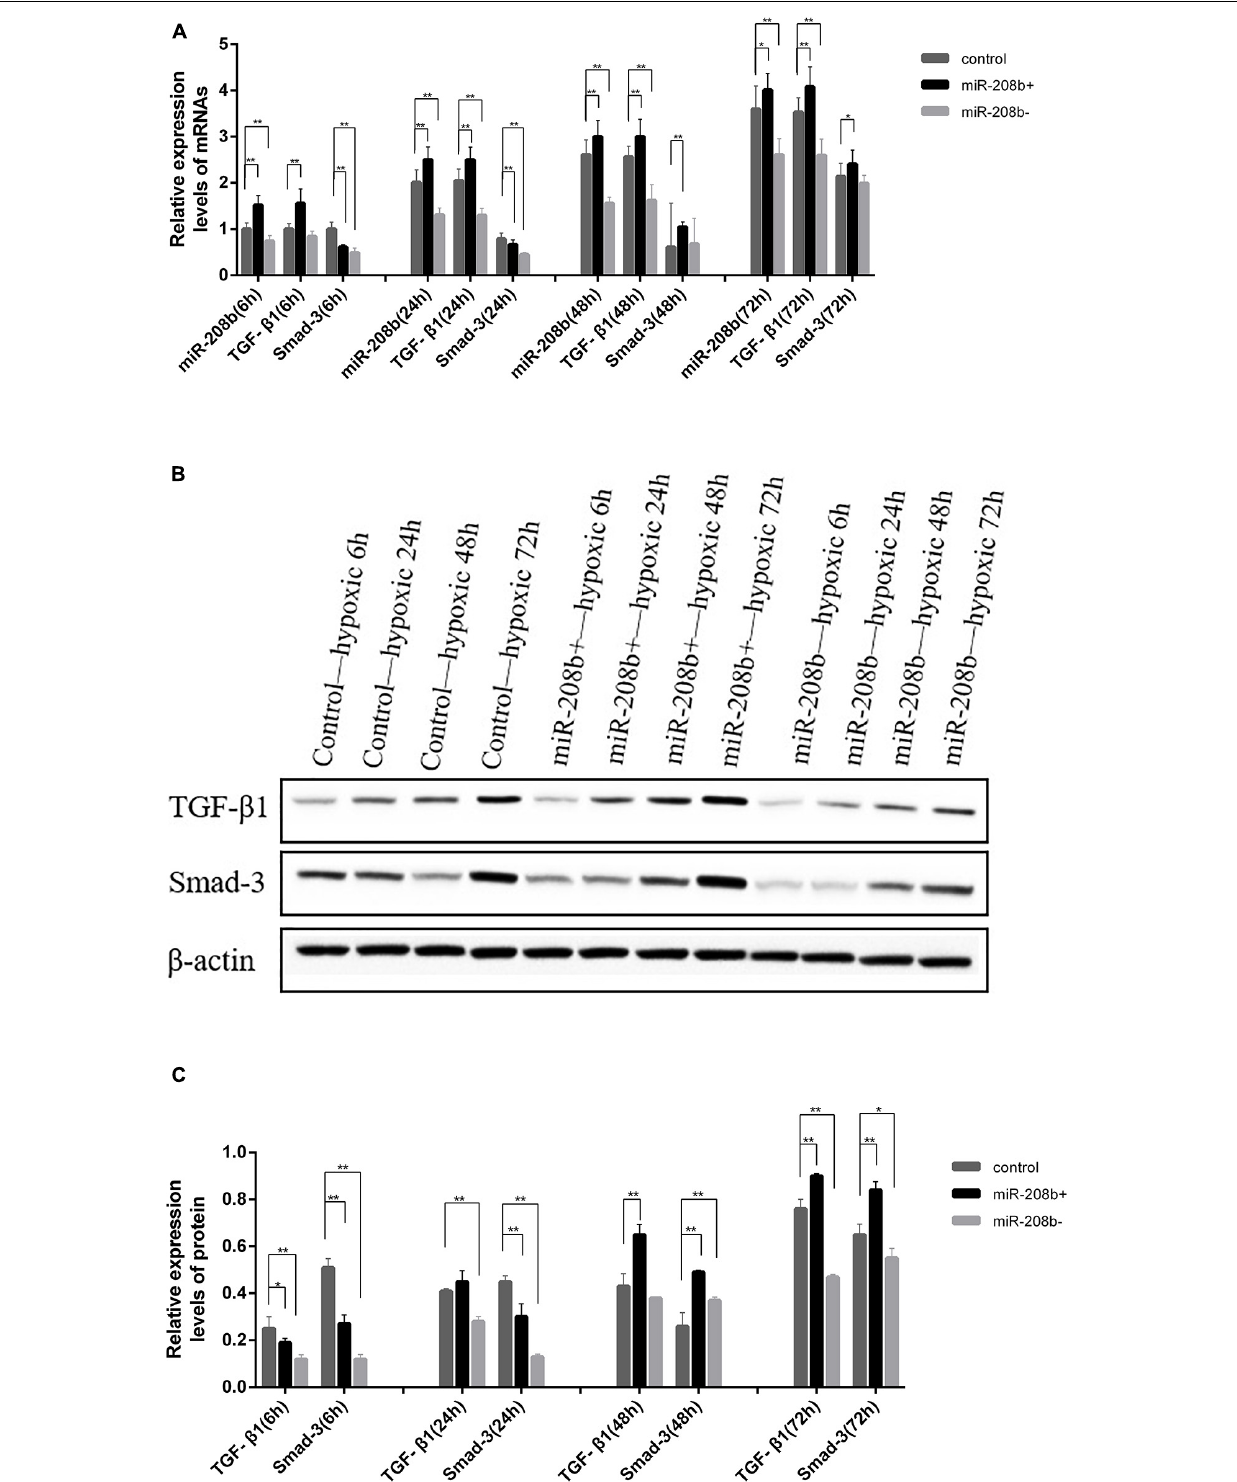
Frontiers in Cardiovascular Medicine |